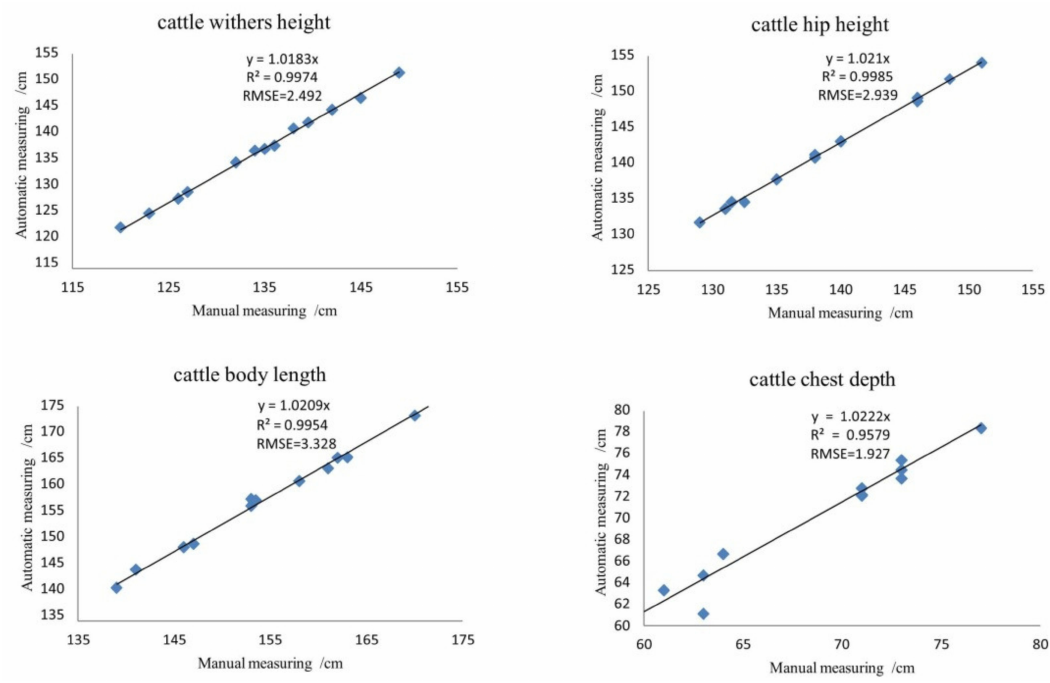
Figure 19. Linear Regression Analysis of cattle body measurement.